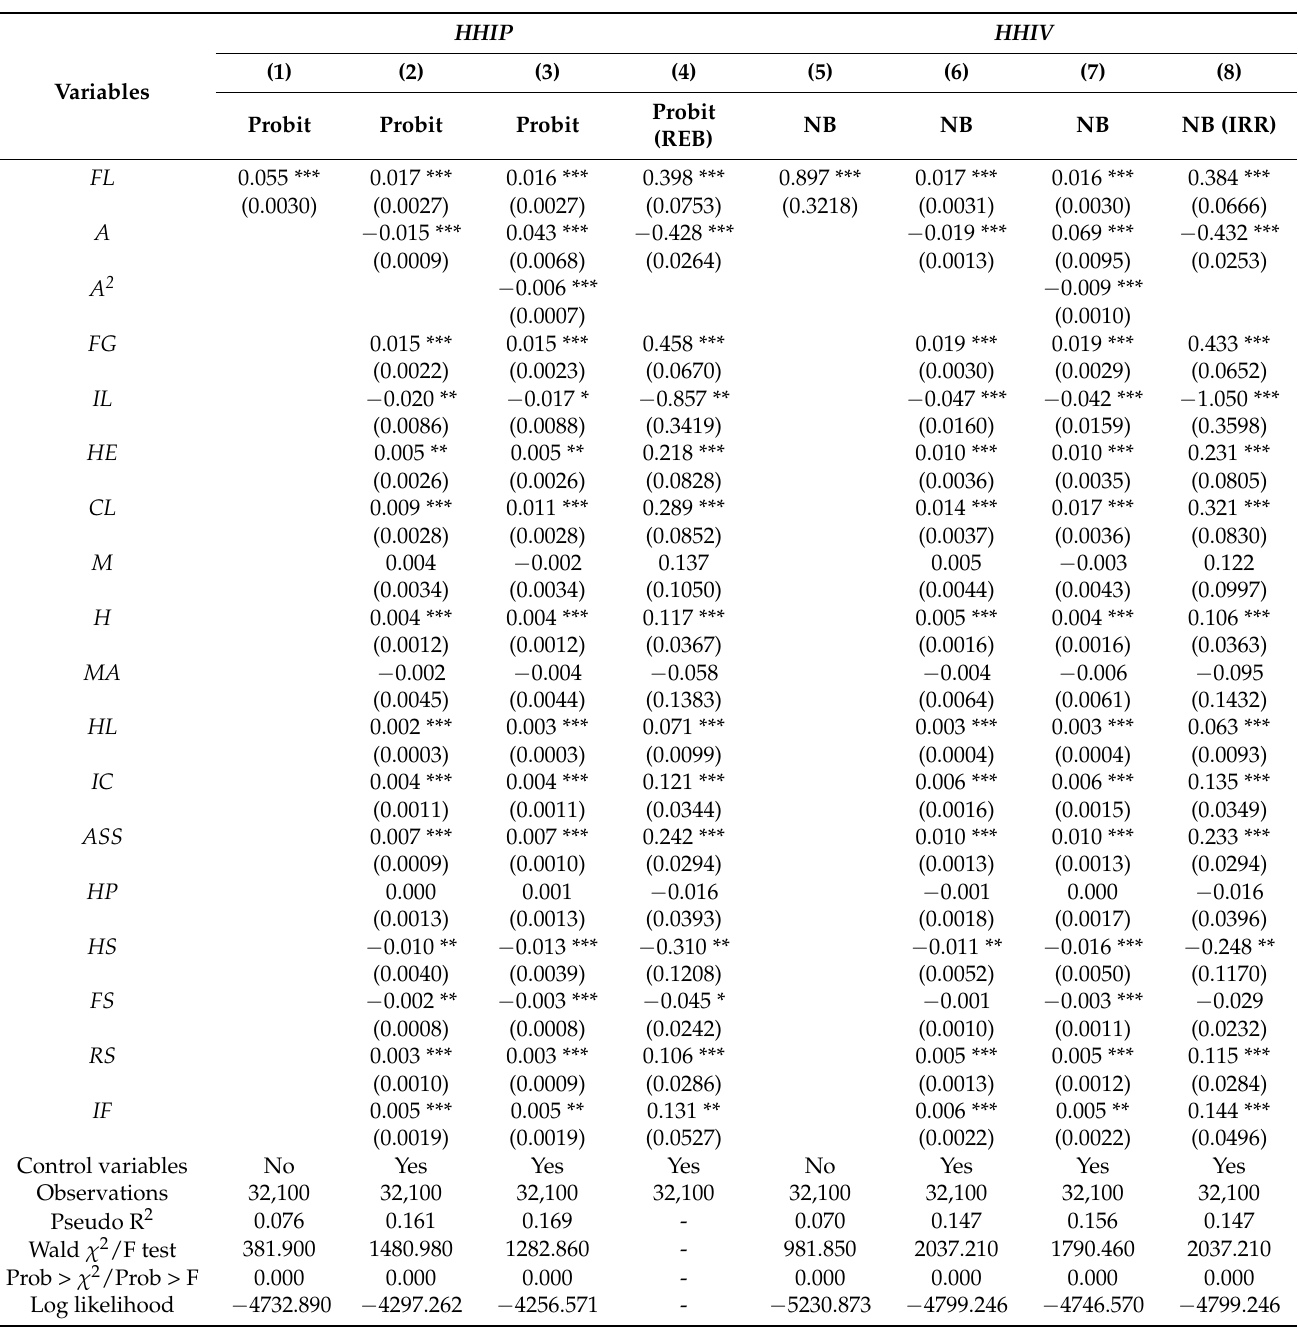
Table 5. Benchmark regression results of financial literacy and household health